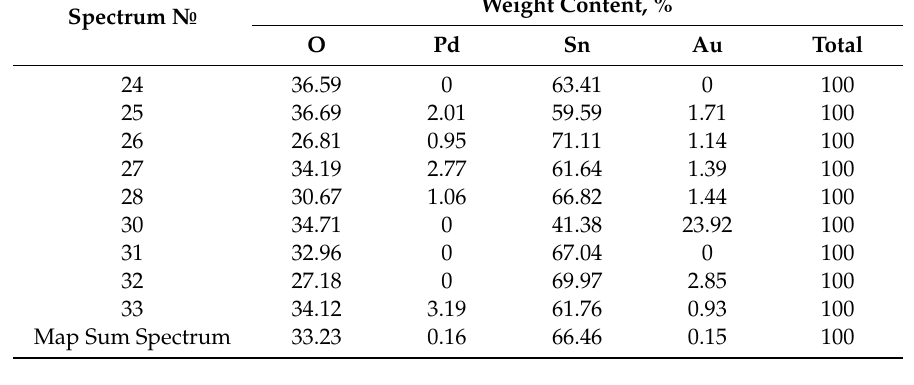
Table 2. Local atomic content of AuPd / SnO 2 nanocomposite components (Figure 2).